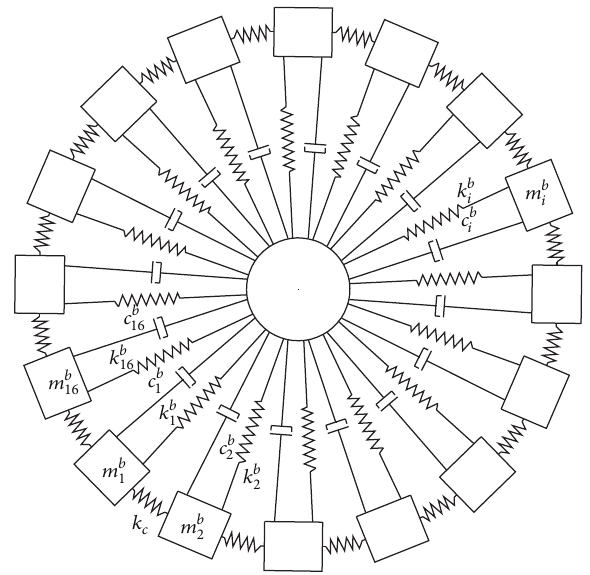
Figure 3: An equivalent lumped-parameter model of coupled